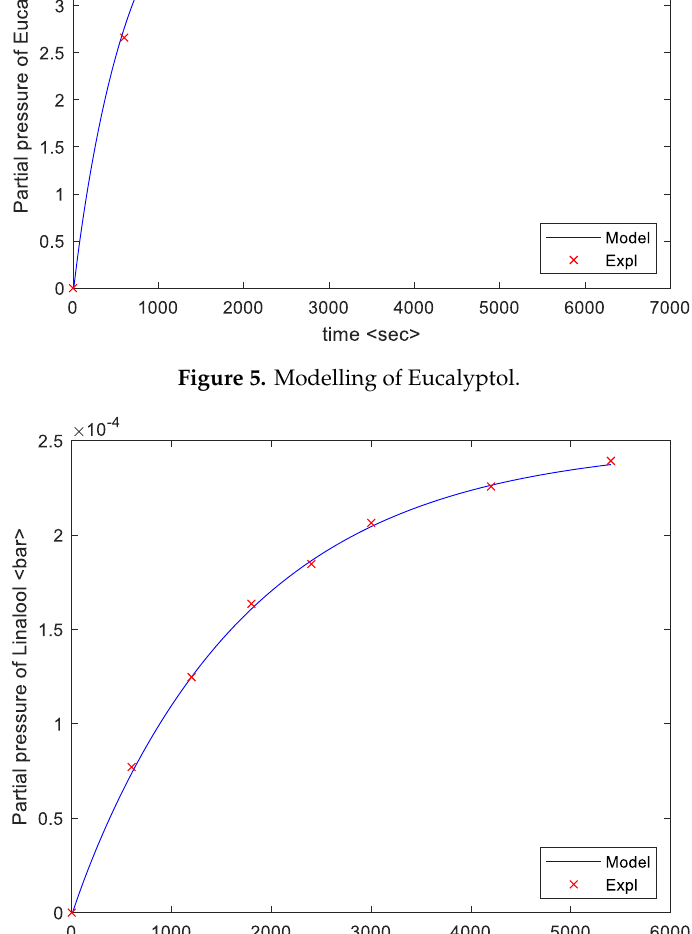
Figure 6. Modelling of Linalool.